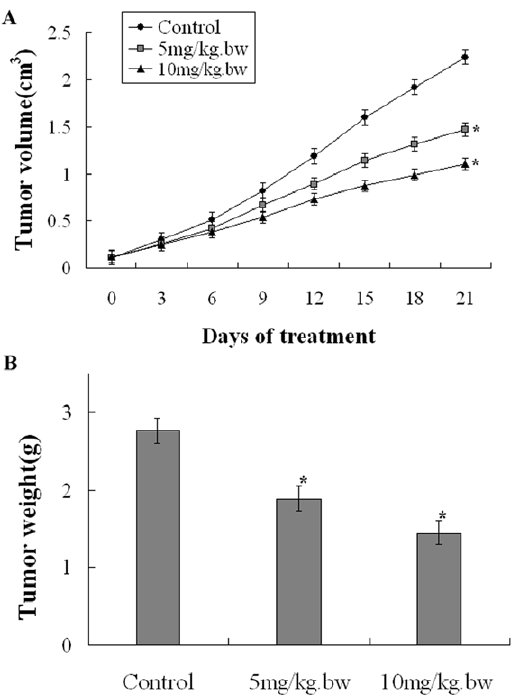
Figure 5. Antitumor effects of fucoidan on breast cancer in vivo. Fucoidan reduced the tumor volume and the tumor weight in Balb/c mice. A) Tumor growth curves. Each point in the curves represents the mean 6 SD (n=7 tumors). The therapy started when the tumors reached a volume of 0.1cm 3 . The fucoidan inhibited tumor growth, * P , 0.05 vs Control. B) Weight of the tumors. Each bar represents the mean 6 SD (n=7 tumors). Mean weights of the tumors are 2.77g, 2.15g, and 1.19g, for the control group, 5 mg/kg.bw and 10mg/kg.bw fucoidan group respectively. * P , 0.05 vs Control.